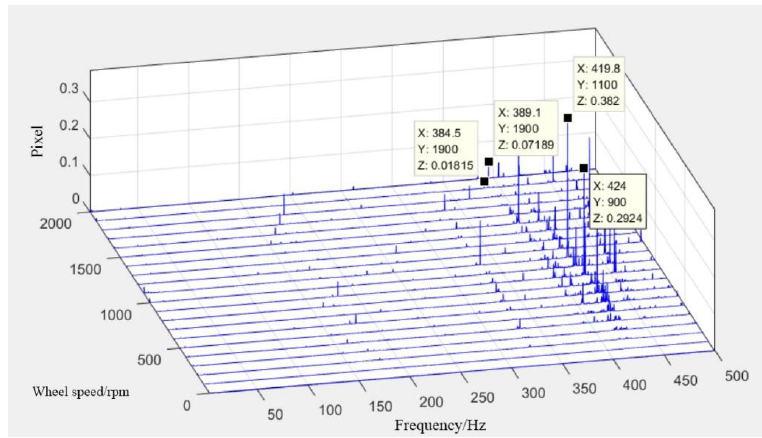
Figure 7. Simulated results of pixel offset vertical to flight direction.